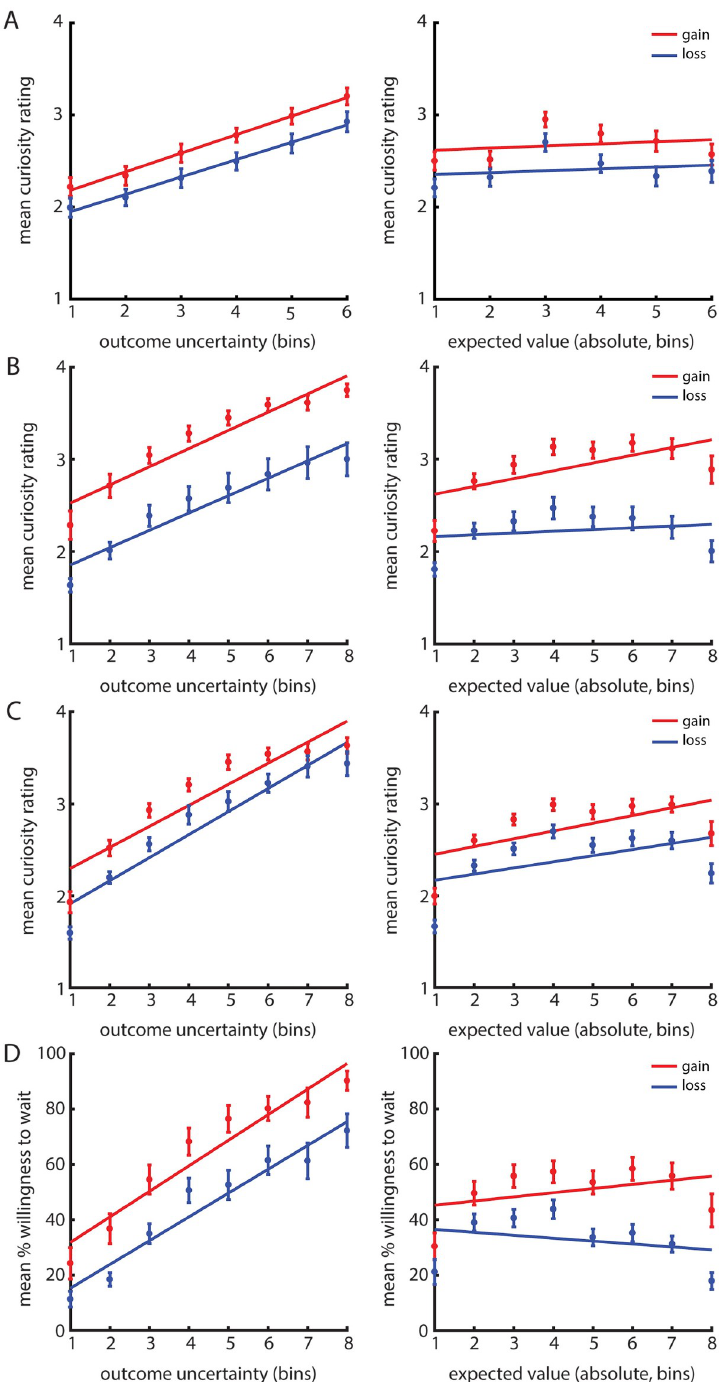
Fig 2. Behavioural results of Experiment 1A (A) Experiment 1B (B), Experiment 1C (C) and Experiment 2 (D). In all panels, the x-axis depicts percentile bins of the levels of outcome uncertainty (left) and the absolute expected values (right) for both gains (in red) and losses (in blue). The y-axis depicts the mean curiosity ratings for each percentile of outcome uncertainty and absolute expected value in the gain and loss context (A, B and C) or the % of trials in which participants were willing to wait for the outcome in the gain and loss context (D). The error bars depict the standard error of the mean (SEM) for each outcome uncertainty and absolute expected value bin of the gains or loss trials. For other details of the data visualization, see Methods – 2 . 5 Data Visualization . A . Experiment 1A showed that